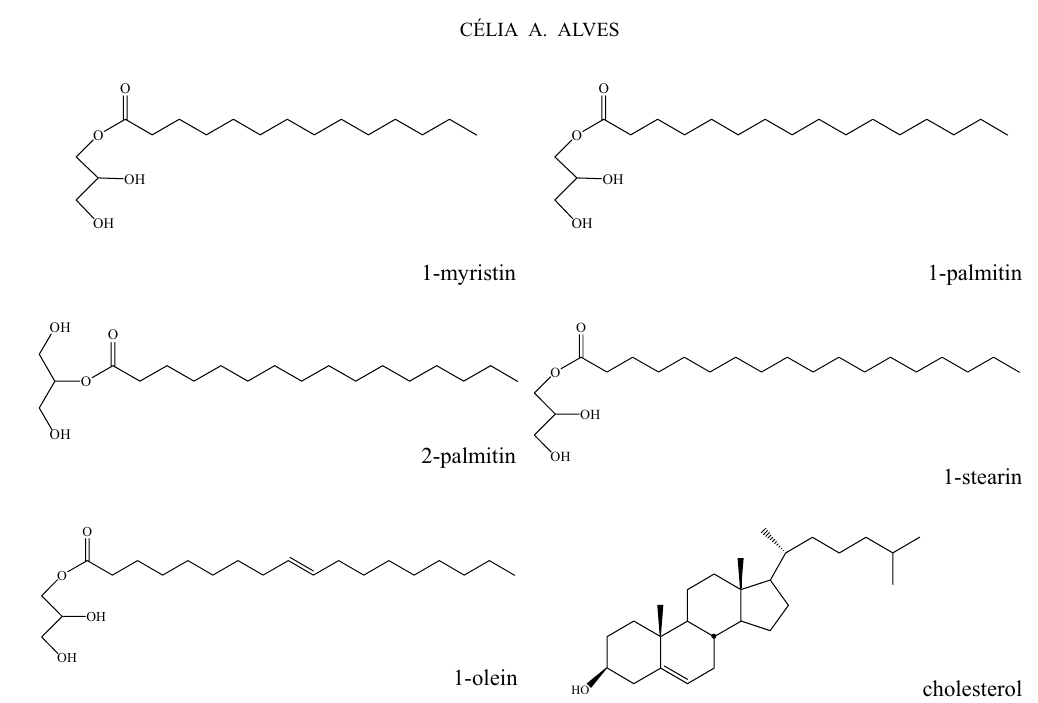
Fig. 2 – Chemical structures of constituents detected in meat